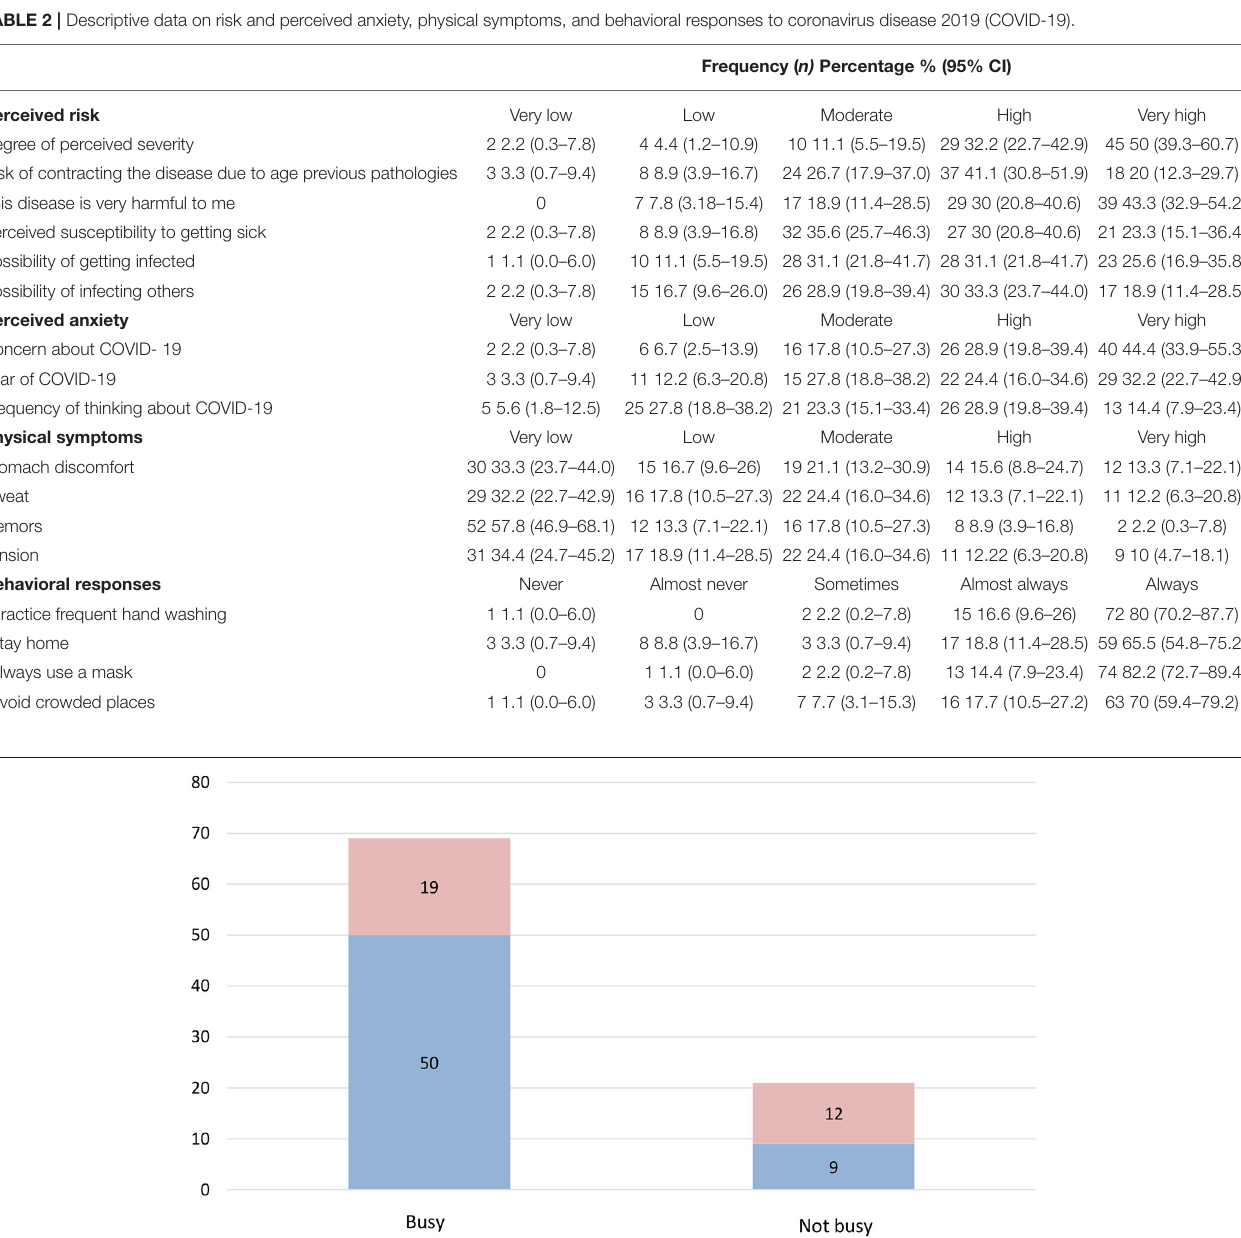
FIGURE 1 | Job situation-perceived